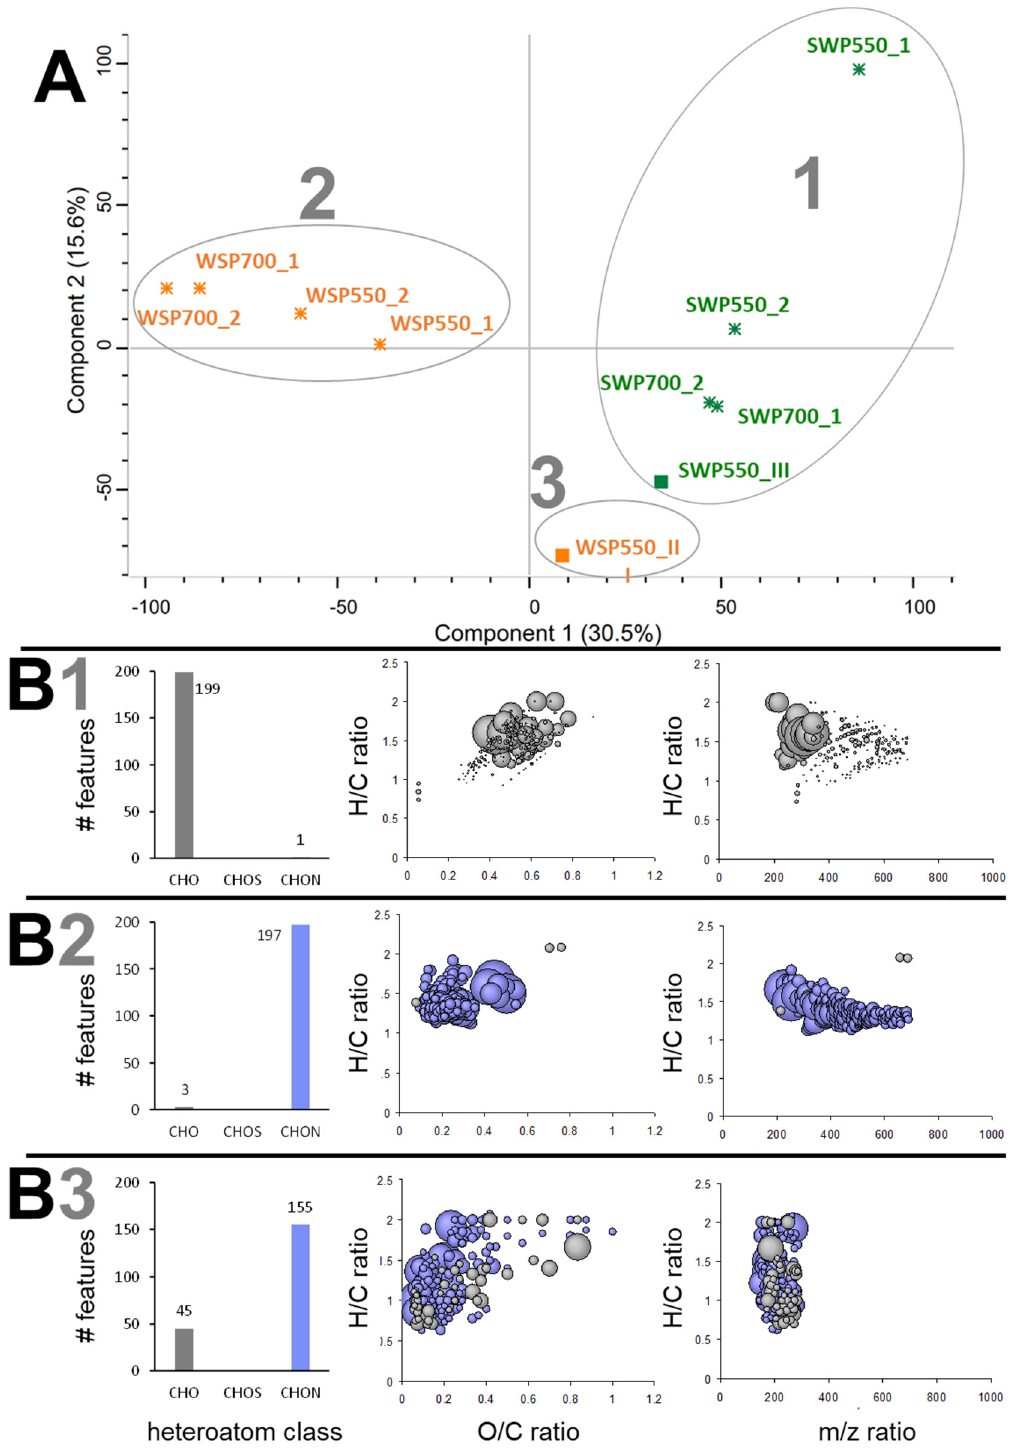
Figure 3. ( A ) Principal component analysis (PCA) score plot of all m/z features from bio-oils measured by ESI (+) FTICR MS. Wheat straw pellets-derived bio-oils in orange, softwood pellets bio-oils in green, small-scale unit bio-oils highlighted by a star and pilot-scale bio-oils by a full square. ( B ) Two hundred features specific to group 1, 2 and 3 observed in panel ( A ) were extracted and represented as (from left to right) bar chart according to their heteroatom classes, van Krevelen diagram (O/C vs. H/C) and m / z vs. H/C-ratios. The bubble size is relative to peak intensity.